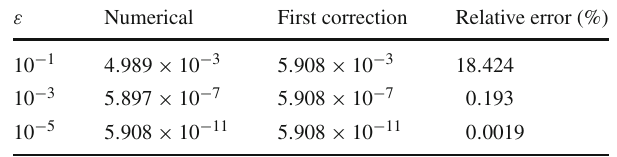
second column shows the numerical result calculated from (24), the third column shows the first order correction given by (25) and the last column shows the relative error between the two approaches